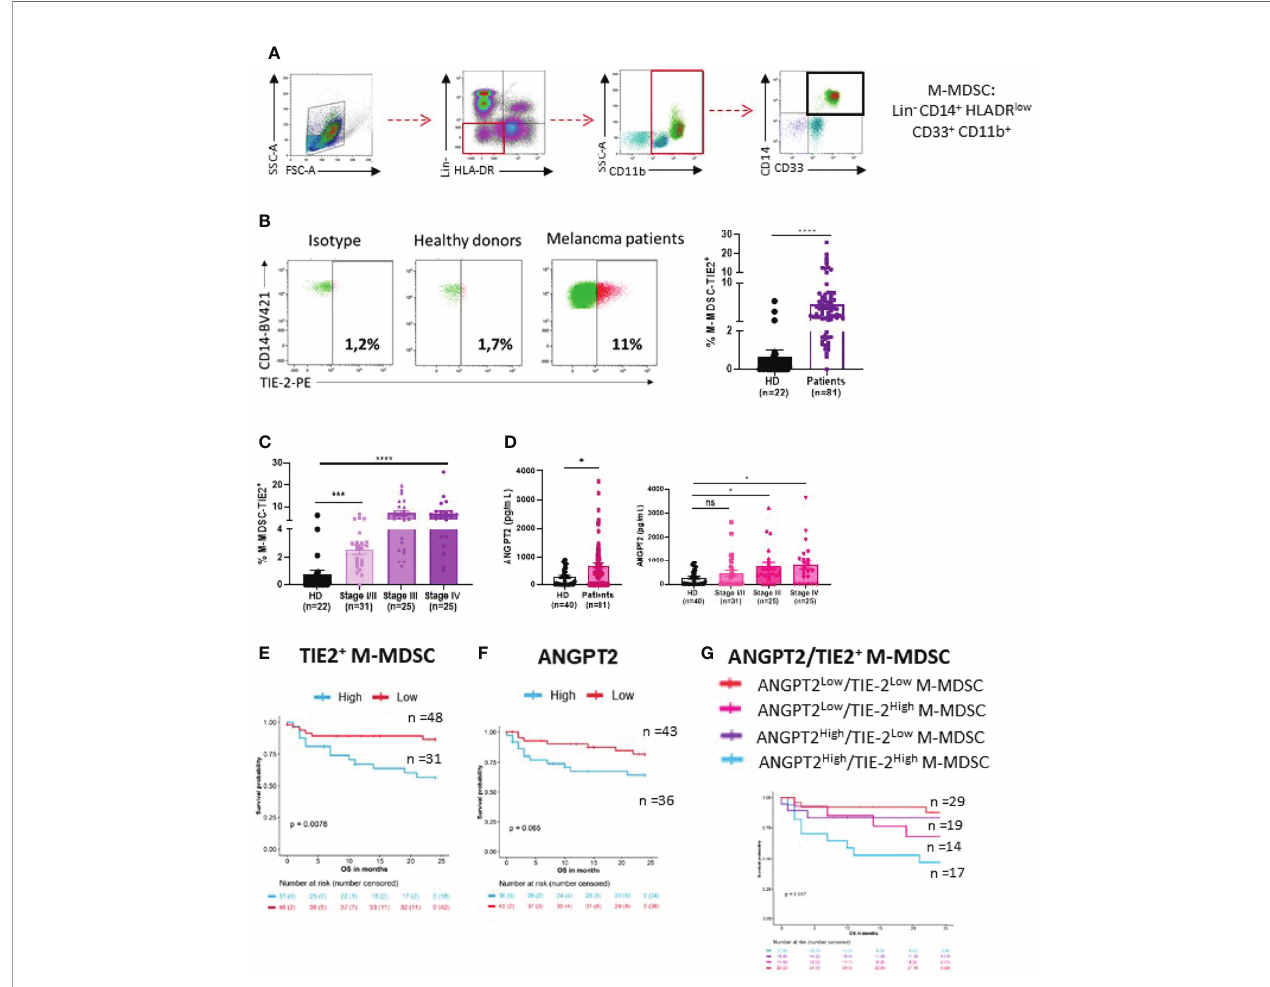
FIGURE 1 | Distribution of TIE-2 + M-MDSC and ANGPT2 in melanoma patients. (A) Gating strategy of M-MDSC (Lineage − , HLA-DR low , CD11b + , CD33 + and CD14 + ). (B) Left, representative dot plot of TIE-2 expressed on M-MDSC from 1 healthy donor (HD) versus 1 melanoma patient gated with isotype; right, percentage of TIE-2 + M- MDSC in HD (n = 22) and in patients (n = 81) (Student ’ s t-test, ****p < 0.0001). (C) Percentage of TIE-2 + M-MDSC according to melanoma disease stages (Student ’ s t- test, ***p<0.001, ****p < 0.0001). (D) Left, level of ANGPT2 serum measured in HD (n = 22) and patient (n = 81); right, according to the disease stage (Student ’ s t-test, *p < 0.01). (E – G) Association between overall survival (OS) and percentage of TIE-2 + M-MDSC (E) , ANGPT2 concentration (F) , and the combination of both parameters (G) . (E) Kaplan – Meier curves according to percentage of TIE-2 + M-MDSC in overall population (p = 0.0079). Thresholds were determined according to the restricted cubic spline method (4.85%). (F) Kaplan – Meier curves according to concentration of ANGPT2 in overall population (p = 0.062). Thresholds were determined according to the restricted cubic spline method (439.5 pg/ml). (G) Patients were classi fi ed into 4 distinct groups according to the level of TIE-2 + M-MDSC and ANGPT2 concentration. Kaplan – Meier curves for the 4 groups in overall population (p = 0.017). ns, no